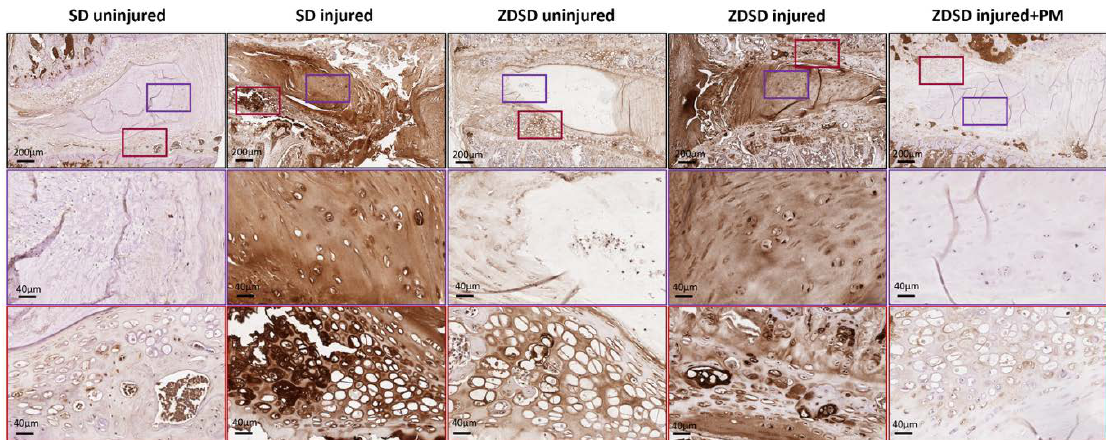
Figure 5. PM treatment reduces AGE levels in injured IVDs and adjacent endplate fibrocartilage. Immunohistochemical AGE staining of IVDs obtained from the various experimental groups harvested at 8 weeks post-surgery. Brown shading indicates positive AGE staining. Upper images show IVDs and adjacent endplates (scale bar: 200 μm). Middle images show magnification of the NP area (in purple rectangles; scale bar: 40 μm). Lower images show magnification of the fibrocartilage of the endplates (red rectangles; scale bar: 40 μm), n ≥ 3 .